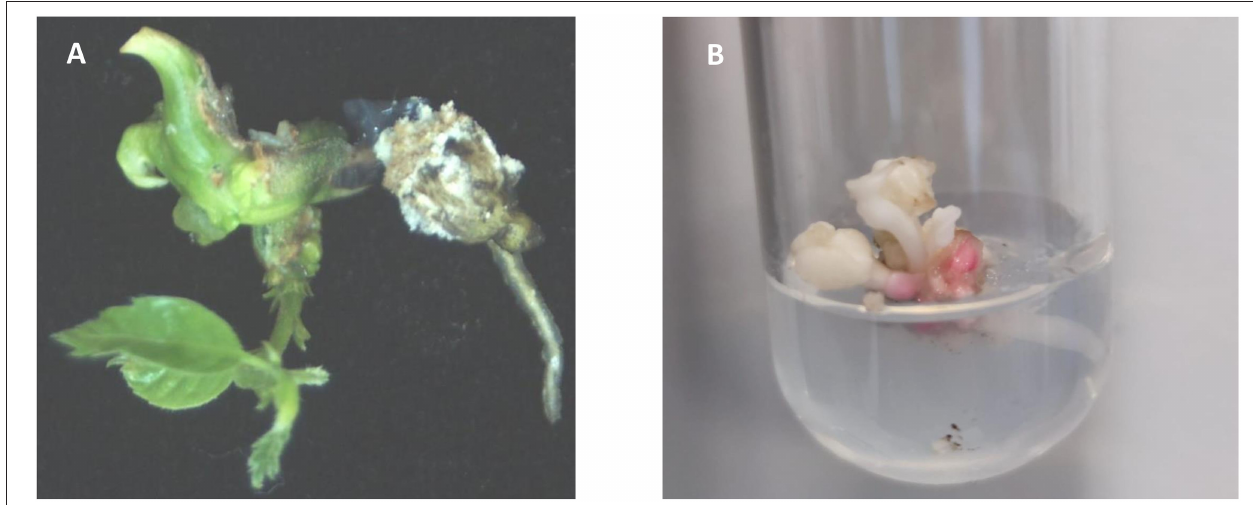
FIGURE 4 | (A) Green plant regenerated from an untransformed somatic embryo. (B) Albino shoot originated from a germinated somatic embryo of transgenic line W1, showing a stunted morphology with shorter internodes and small leaves.